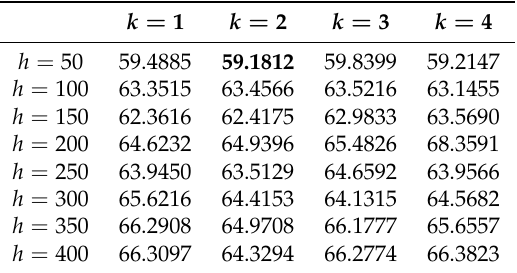
Table 3. Root-mean-square errors (RMSEs) of the 60 min prediction experiment with various numbers of hidden layers and hidden